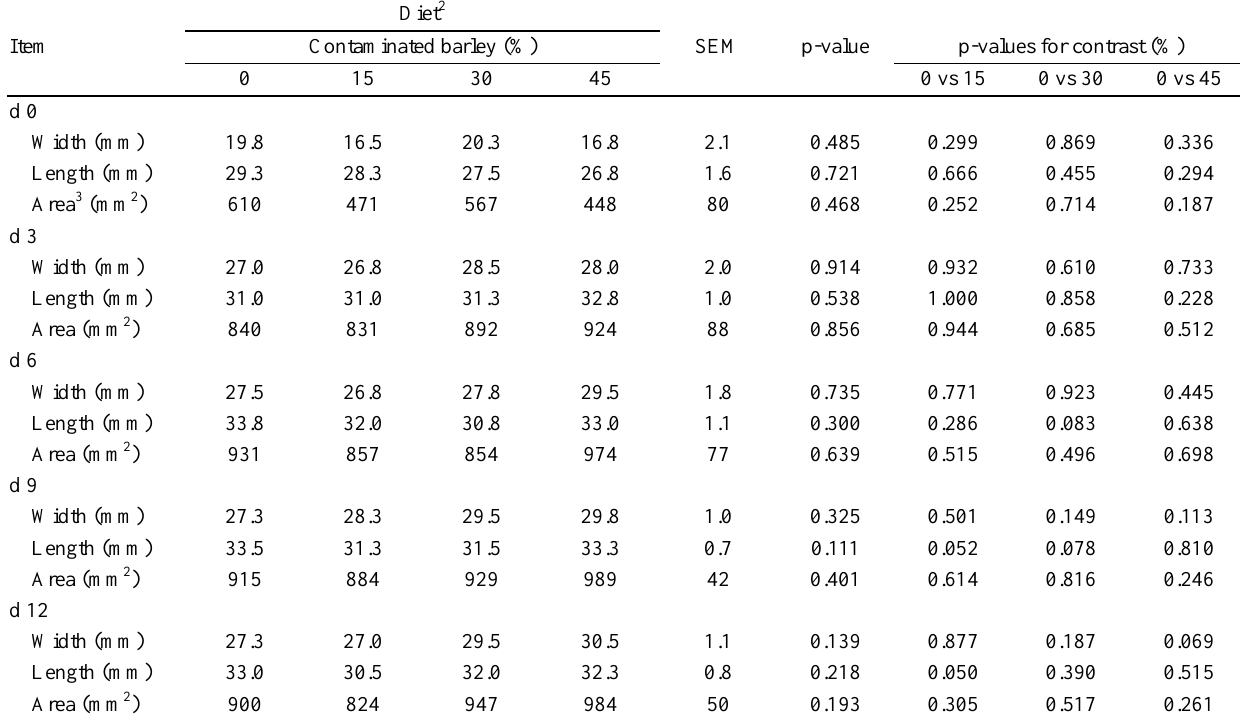
Table 9. Vulva size of pigs fed the recovery diet 1 , Exp.